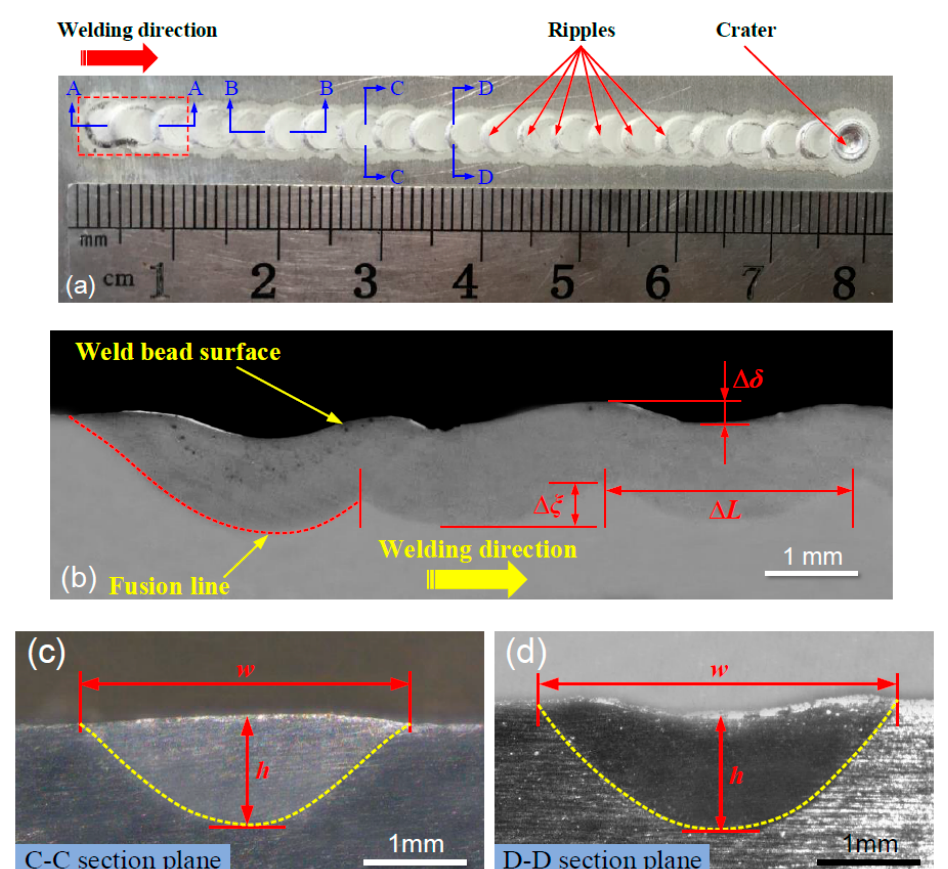
Figure 4. Experimental weld bead shapes for GTA welds achieved under the following conditions: I en / I ep = 240/120 A, f = 3 Hz, and u = 7 mm/s, showing the ( a ) top view of weld bead, ( b ) longitudinal view of the weld, ( c ) transverse cross-section of the weld at the hump, and ( d ) transverse cross-section at a concave weld bead profile.